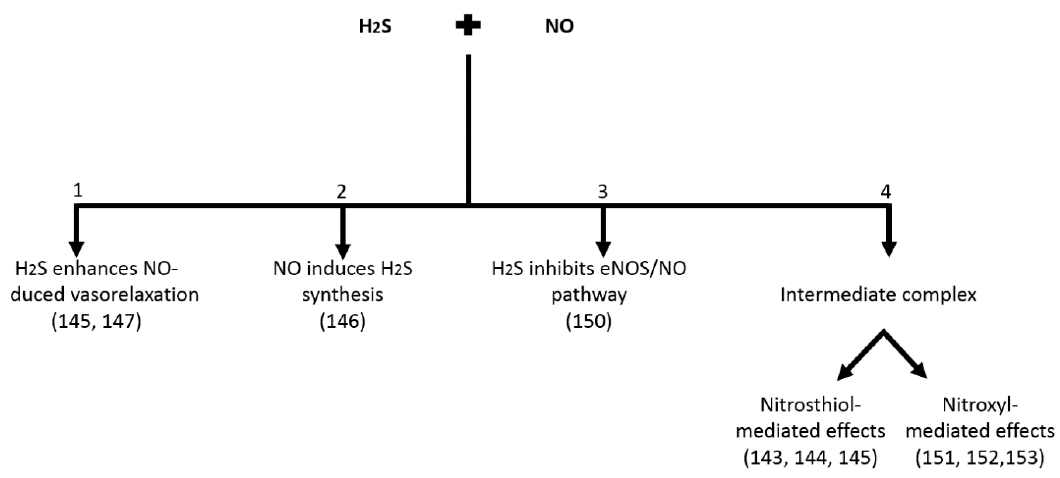
Figure 3. Overall summary of interactions described between H 2 S and NO in living system.